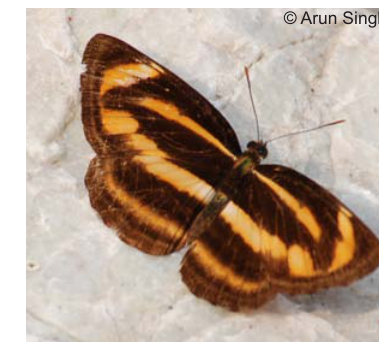
Image 43. Yellow Sailer Neptis ananta